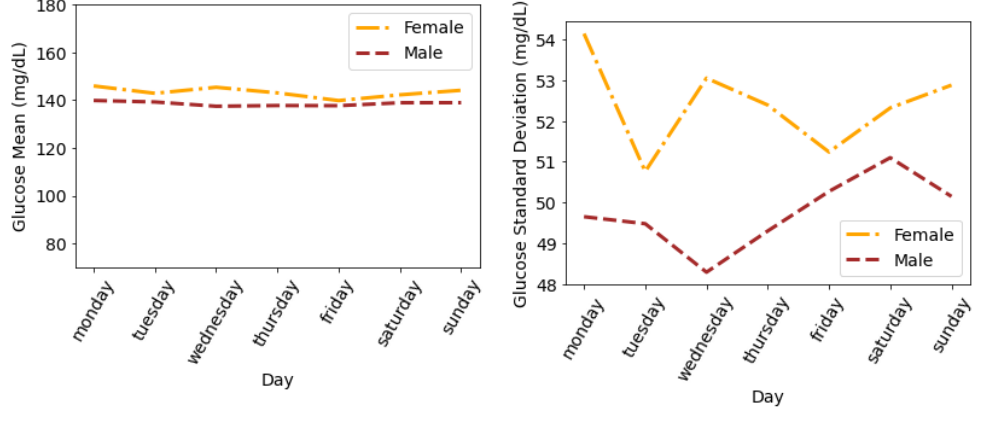
Figure 6. Average glucose mean and standard deviation for insulin-requiring individuals in OpenAPS Data Commons dataset during days of the week based on gender. Total number of males and females is 50 and 28, respectively.